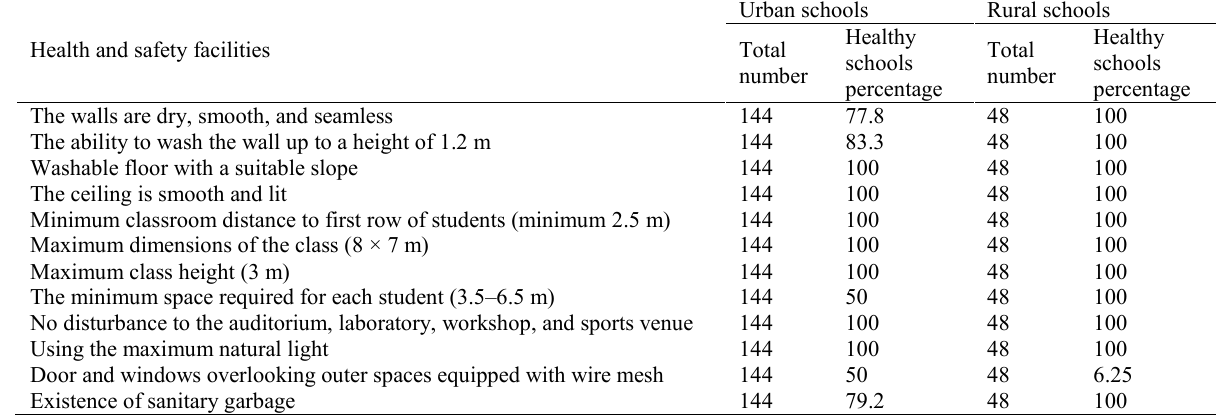
Table 3. Results of health condition of schools in Abadan from the point of view of health and safety facilities. Health and safety facilities